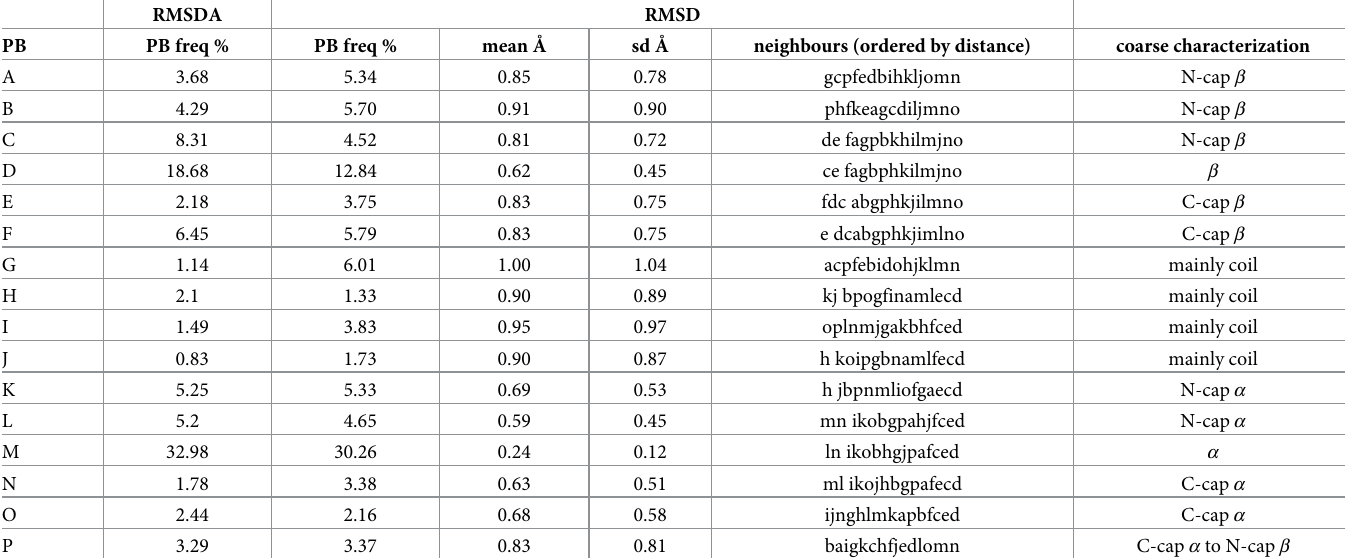
Table 1. Description of protein clusters in terms of RMSD. RMSDA RMSD